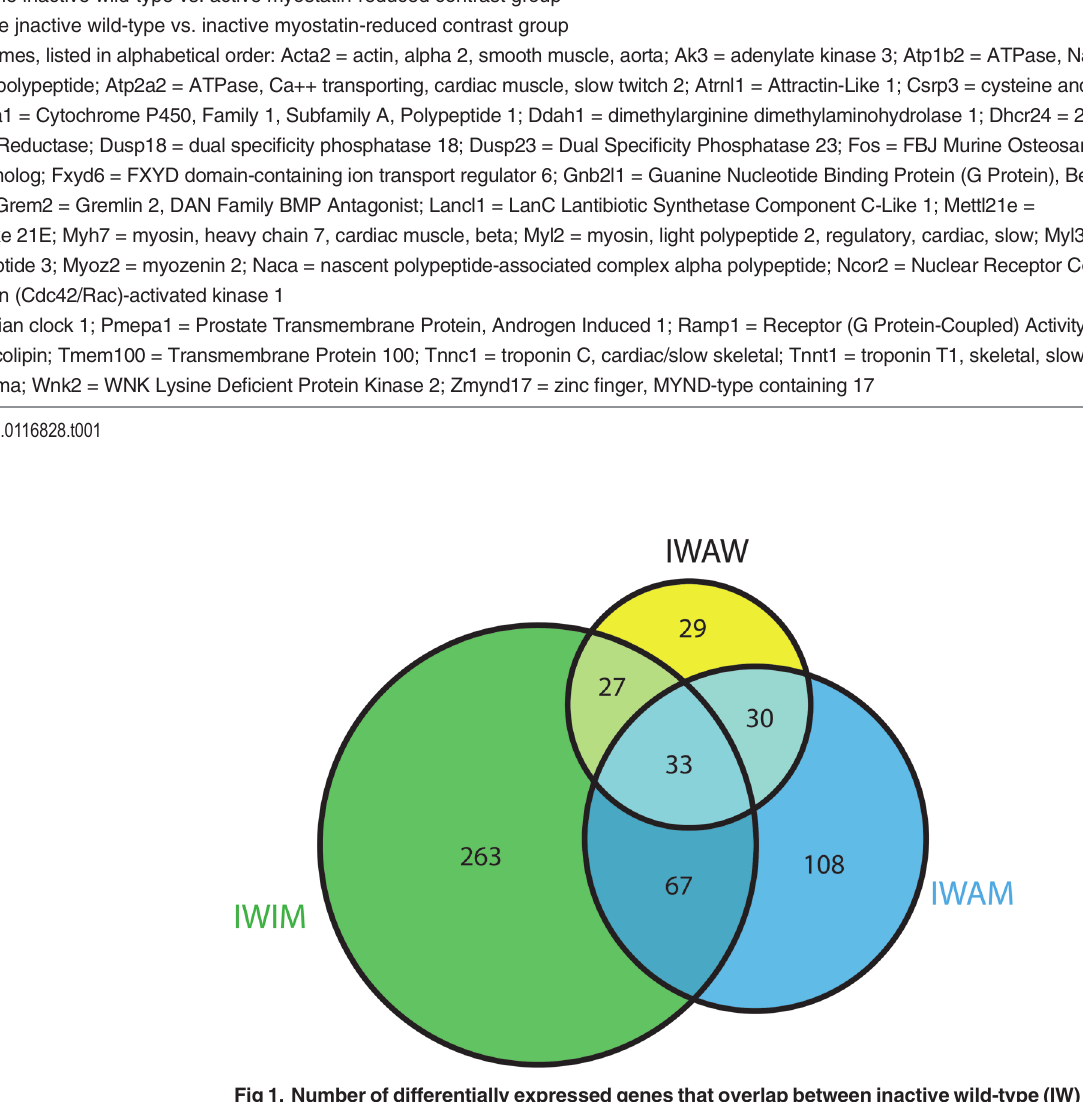
Fig 1. Number of differentially expressed genes that overlap between inactive wild-type (IW) and remainder activity-genotype groups: inactive myostatin-reduced (IM), active wild-type (AW), and active myostatin-reduced